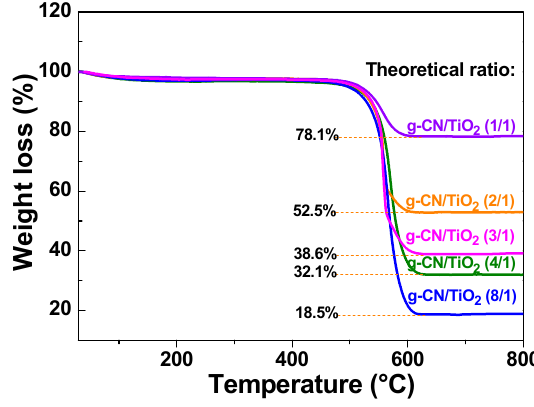
Figure 5. Thermogravimetric curves of g-CN/TiO 2 composites. Table 1. Theoretical and actual g-CN:TiO 2 ratios determined by thermogravimetric analysis (TGA) analyses.